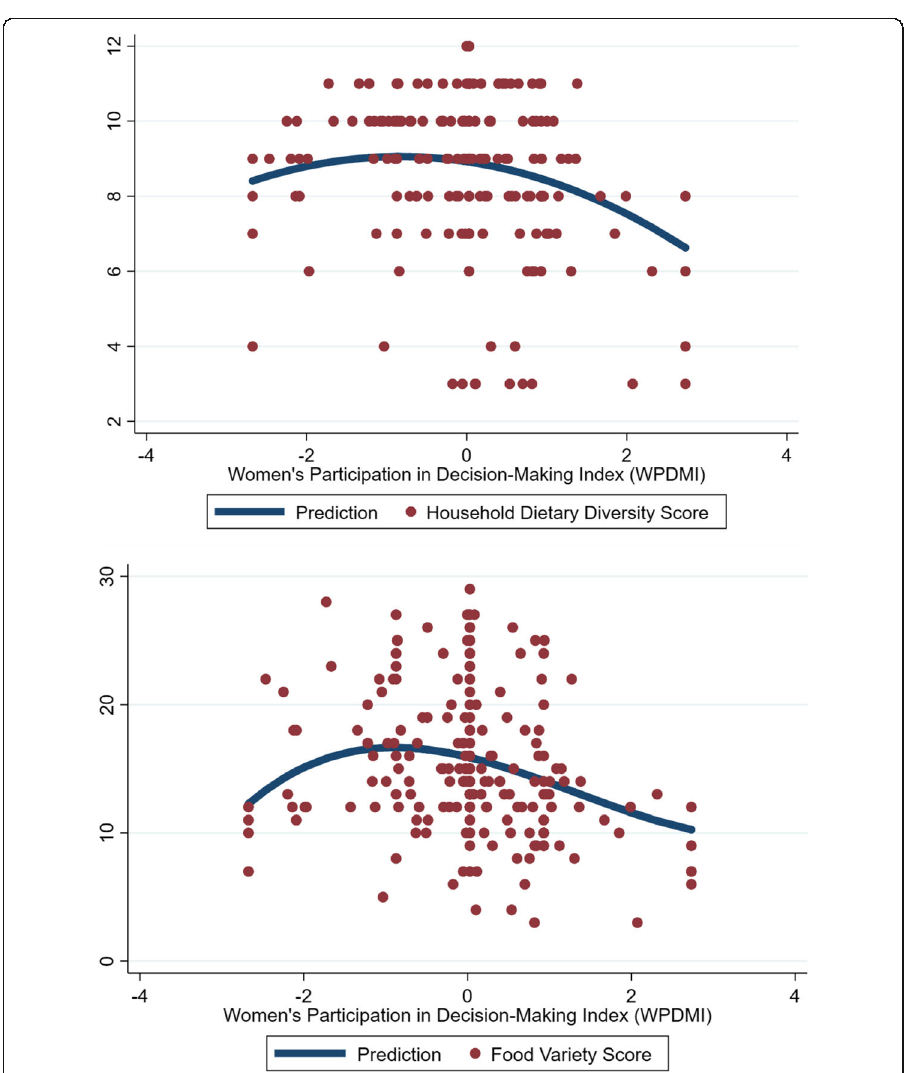
Fig. 3 Estimated quadratic and cubic regression graphs of WPDMI on HDDS and FVS, respectively. Source: Authors ’